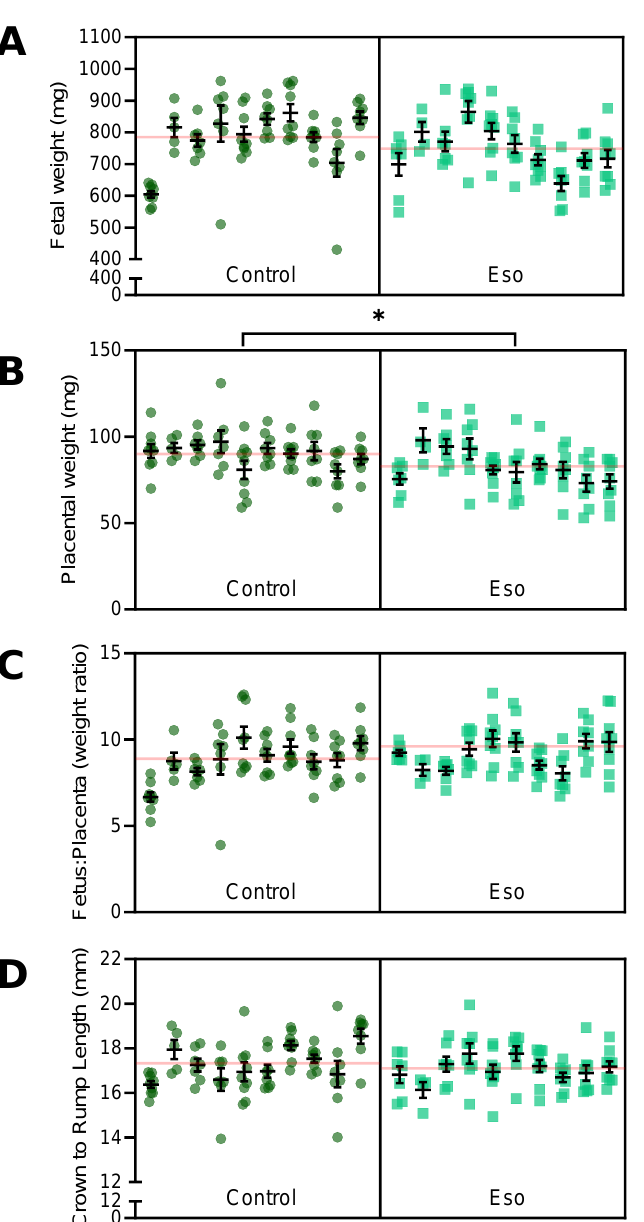
Figure 9. Effect of esomeprazole on foetal and placental weight and size in obese L-NAME mice administered L-NAME. ( A ) Foetal weight, ( B ) placental weight, ( C ) foetal to placental weight ratio, and ( D ) crown to rump length (measured with digital callipers). Esomeprazole administration did not significantly improve foetal weight or length. Placental weight was significantly reduced in the obese L-NAME mice administered esomeprazole. The ratio of foetal to placental weight was not significantly altered. Results are presented from each dam (n = 10 mice/group), mean ± SEM. The red line across each box represents the mean of each group. * p < 0.05.